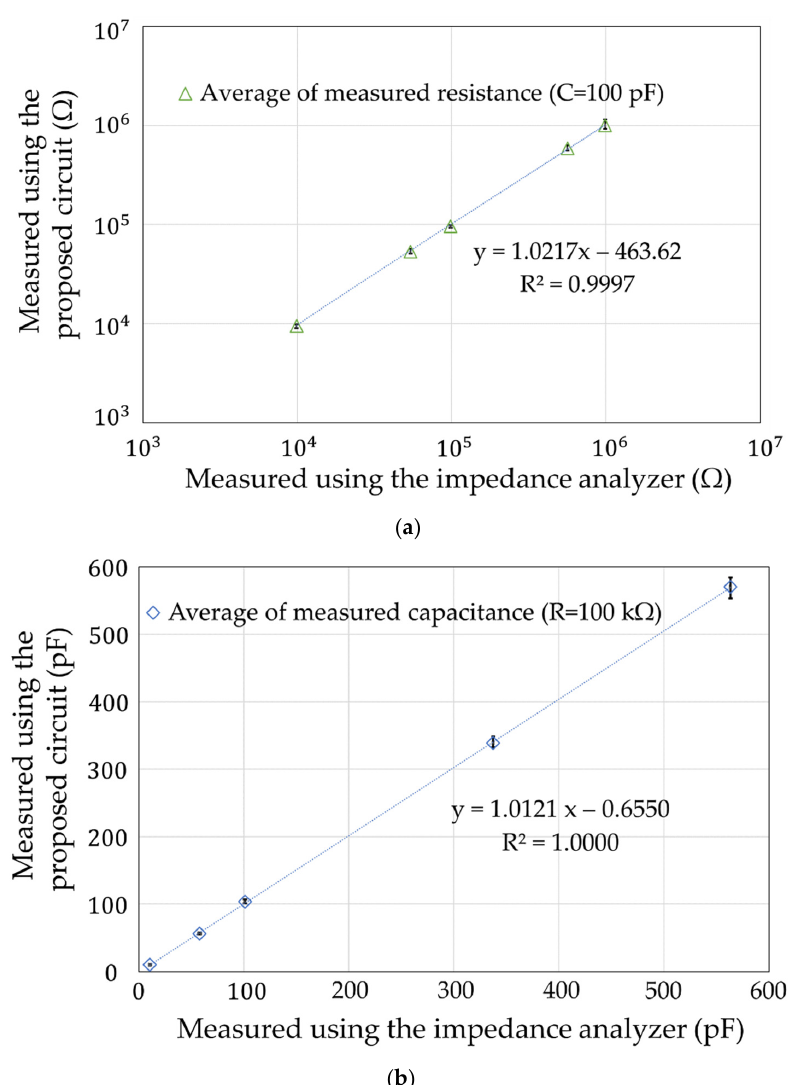
Figure 13. Calculation accuracy. ( a ) About resistance. ( b ) About capacitance.